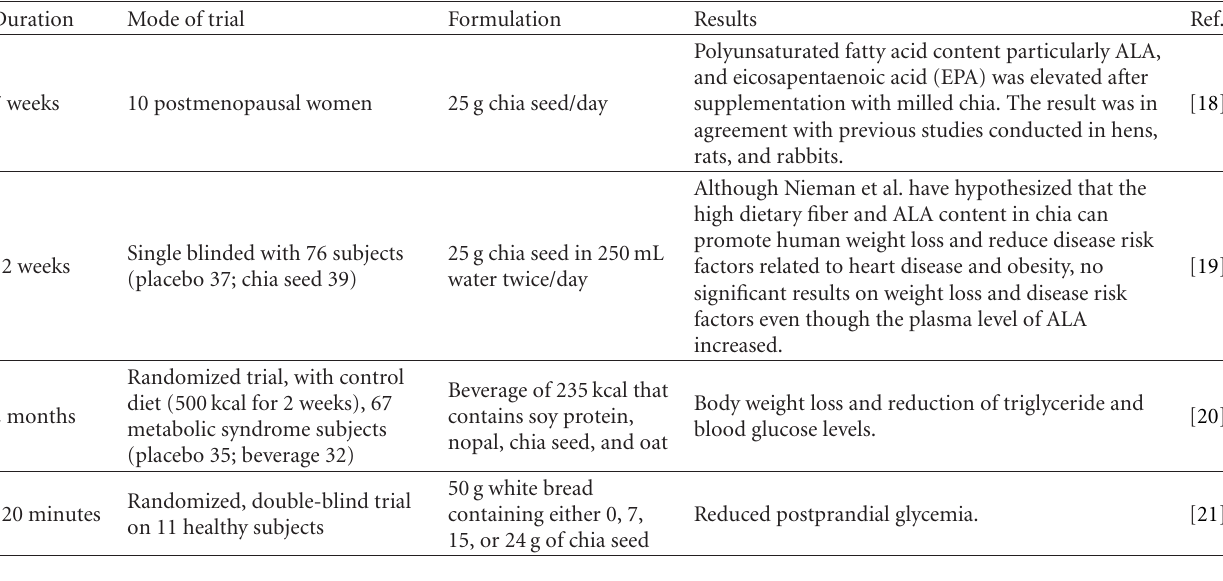
Table 2: Human clinical trials of chia seed.